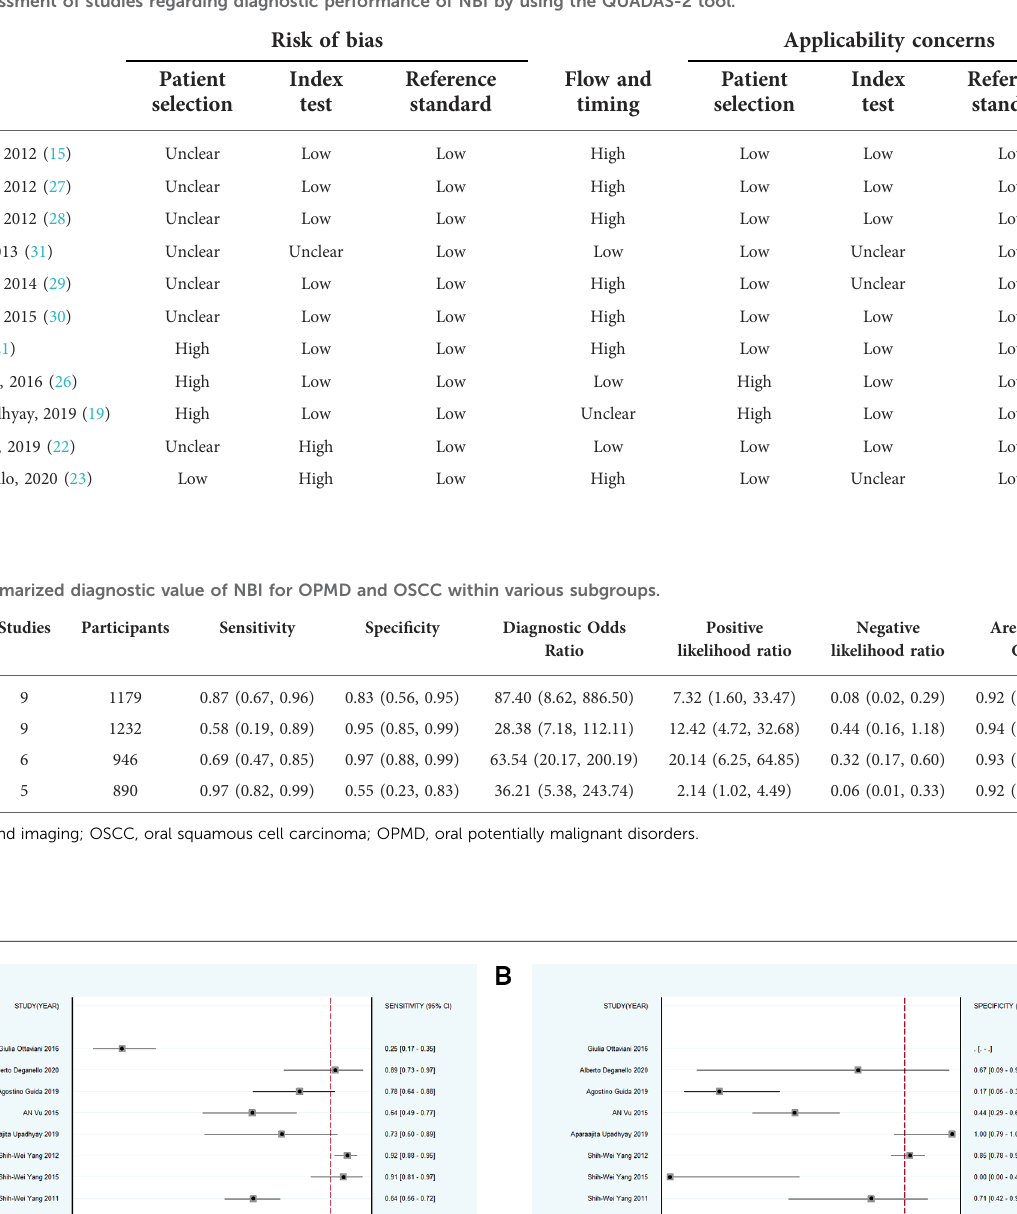
TABLE 3 Assessment of studies regarding diagnostic performance of NBI by using the QUADAS-2 tool.